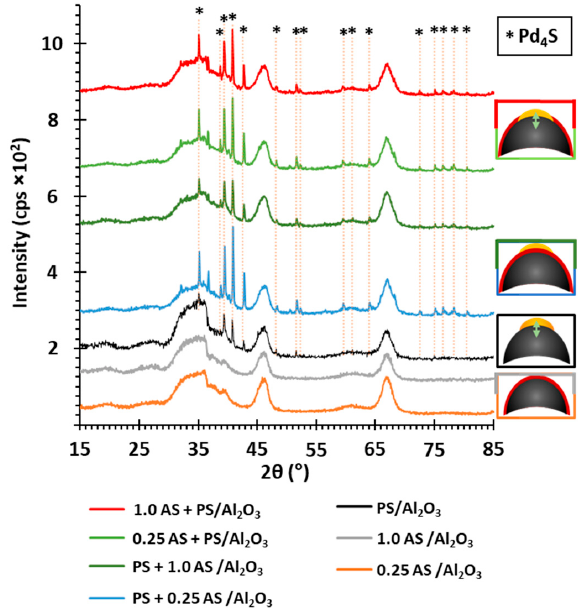
Figure 4. Powder X-ray di ff raction results of alumina-supported sulfates together with characteristic peaks of Pd 4 S (*) after temperature-programmed reduction treatment under hydrogen